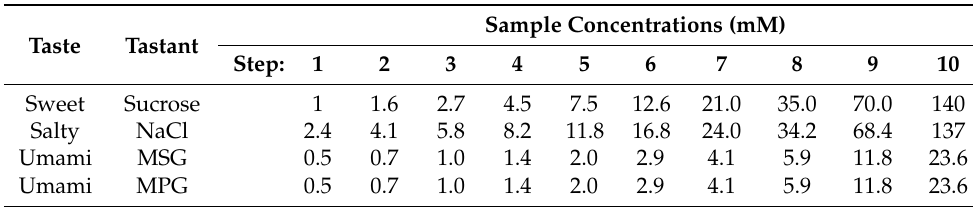
Table 1. Tastes and tastants used in taste assessment and the respective sample concentration steps (1–10) and concentrations